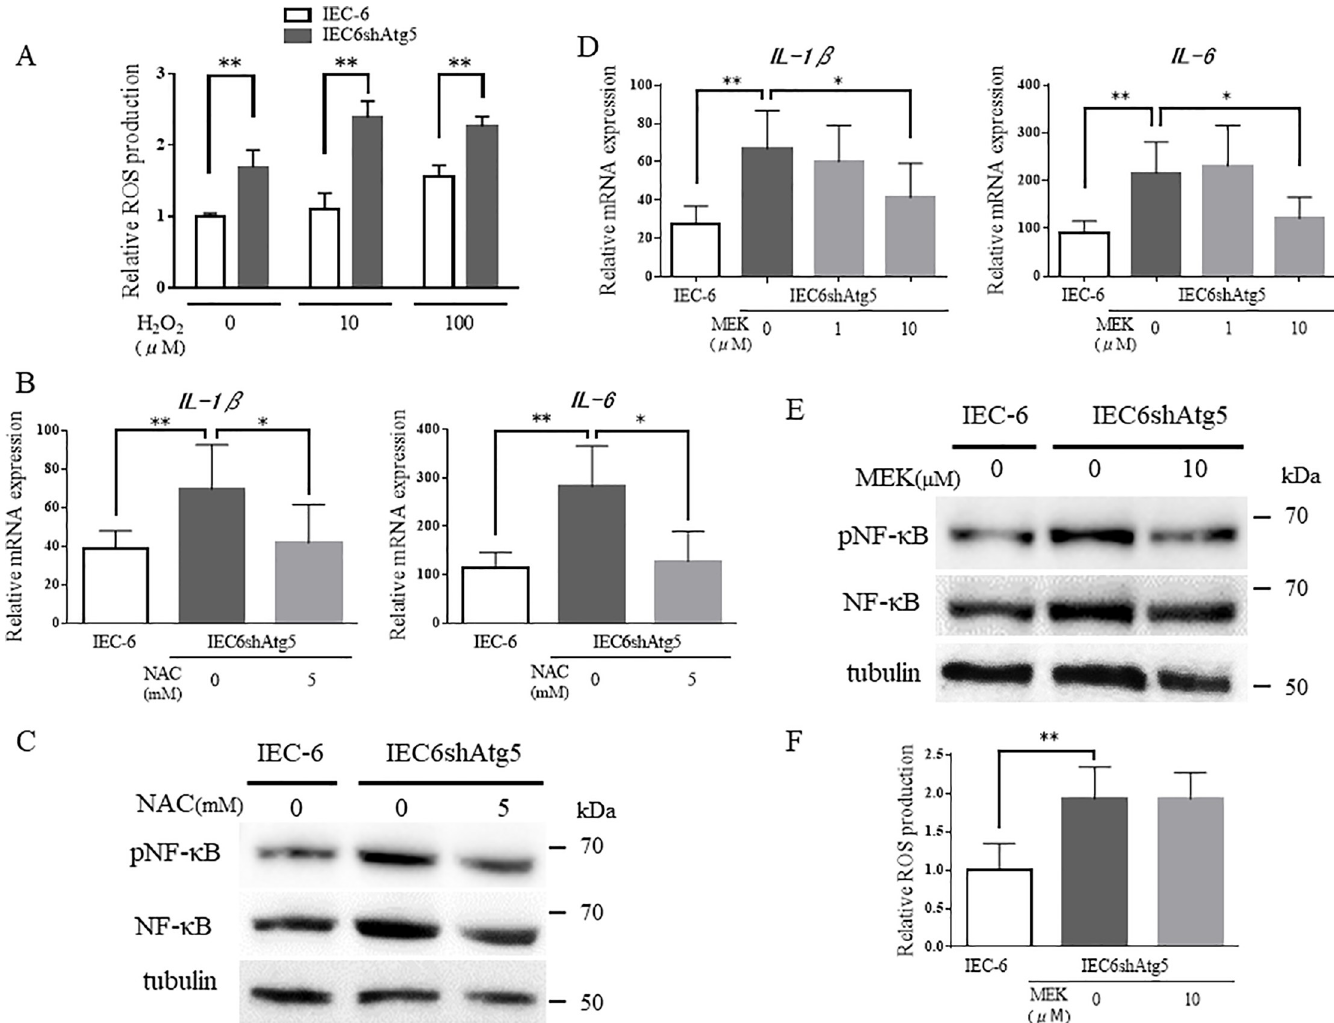
Fig 5. Inhibition of autophagy induces the accumulation of ROS and activation of the MAPK signaling pathway. (A) Total ROS levels in IEC-6 and IEC6shAtg5 cells after H 2 O 2 treatment. Cells were treated with 0, 10, and 100 μ M H 2 O 2 for 24 h, and total ROS levels were evaluated with the Total ROS Detection Kit (Enzo Life Sciences Inc., NY) (B) mRNA expression of proinflammatory cytokine genes in IEC-6 and IEC6shAtg5 cells after ROS removal. Cells were treated with 0, 1, and 5 mM NAC, and mRNA expression of IL-1 β and IL-6 were determined by qPCR. (C) pNF- κ B p65 and pERK protein expression levels in IEC6shAtg5 cells after ROS removal. Cells were treated with or without 5 mM NAC for 24 h, and the expression levels were determined by Western blot analyses. (D) mRNA expression levels of proinflammatory cytokines in IEC6shAtg5 cells treated with a MEK inhibitor, PD98059. Cells were treated with 0, 1, 10, and 100 μ M PD98059, and mRNA expression of IL-1 β and IL-6 were determined by qPCR. � p < 0.05, �� p < 0.01. (E) pNF- κ B p65 and pERK protein expression levels in IEC-6 and IEC6shAtg5 cells after PD98059 treatment. Cells were treated with or without 10 μ M PD98059, and the expression levels were determined by Western blot analyses. (F) Total ROS levels in IEC-6 and IEC6shAtg5 cells with or without PD98059. Cells were treated with 0, 10, 100 μ M of a MEK inhibitor, PD98059, and mRNA expression of IL-1 β and IL-6 was determined by qPCR. � p < 0.05, �� p <